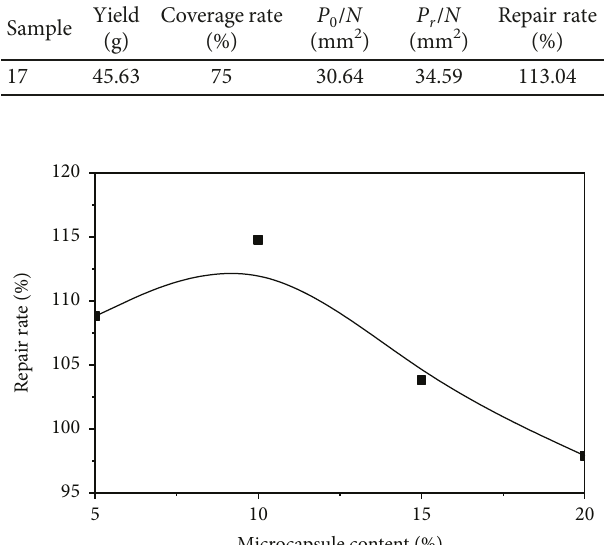
Figure 7: Repair rate of samples with di ff erent microcapsule